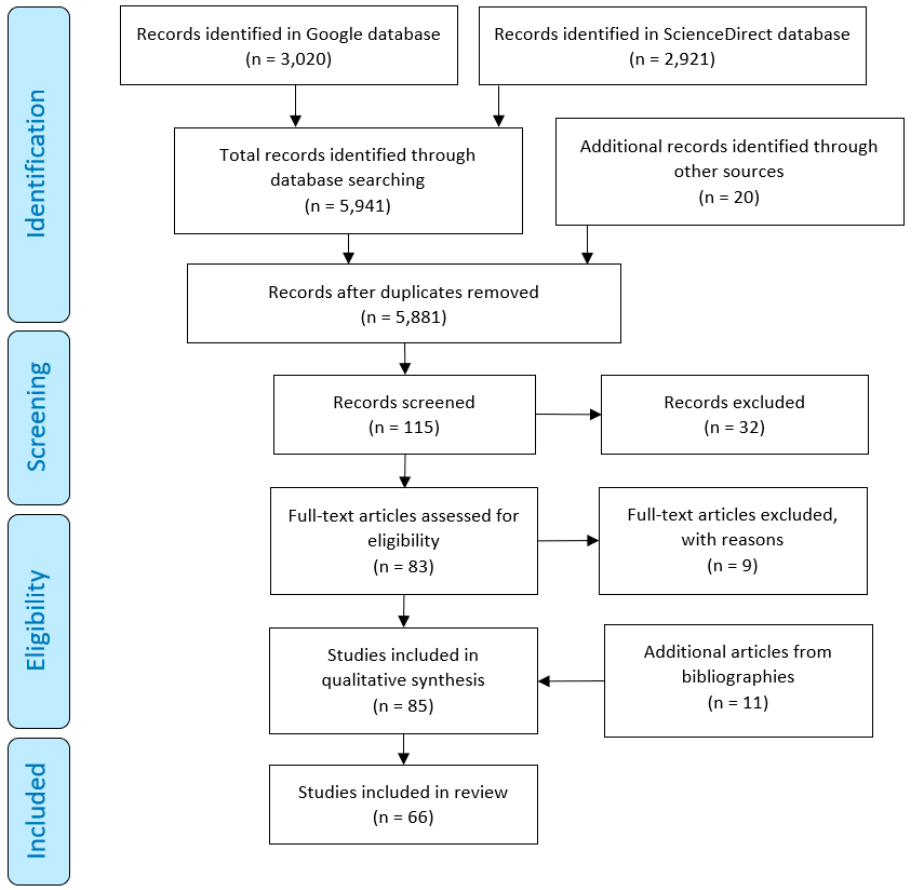
Figure 2. Search strategy and selection of studies in the Google Scholar and ScienceDirect databases.